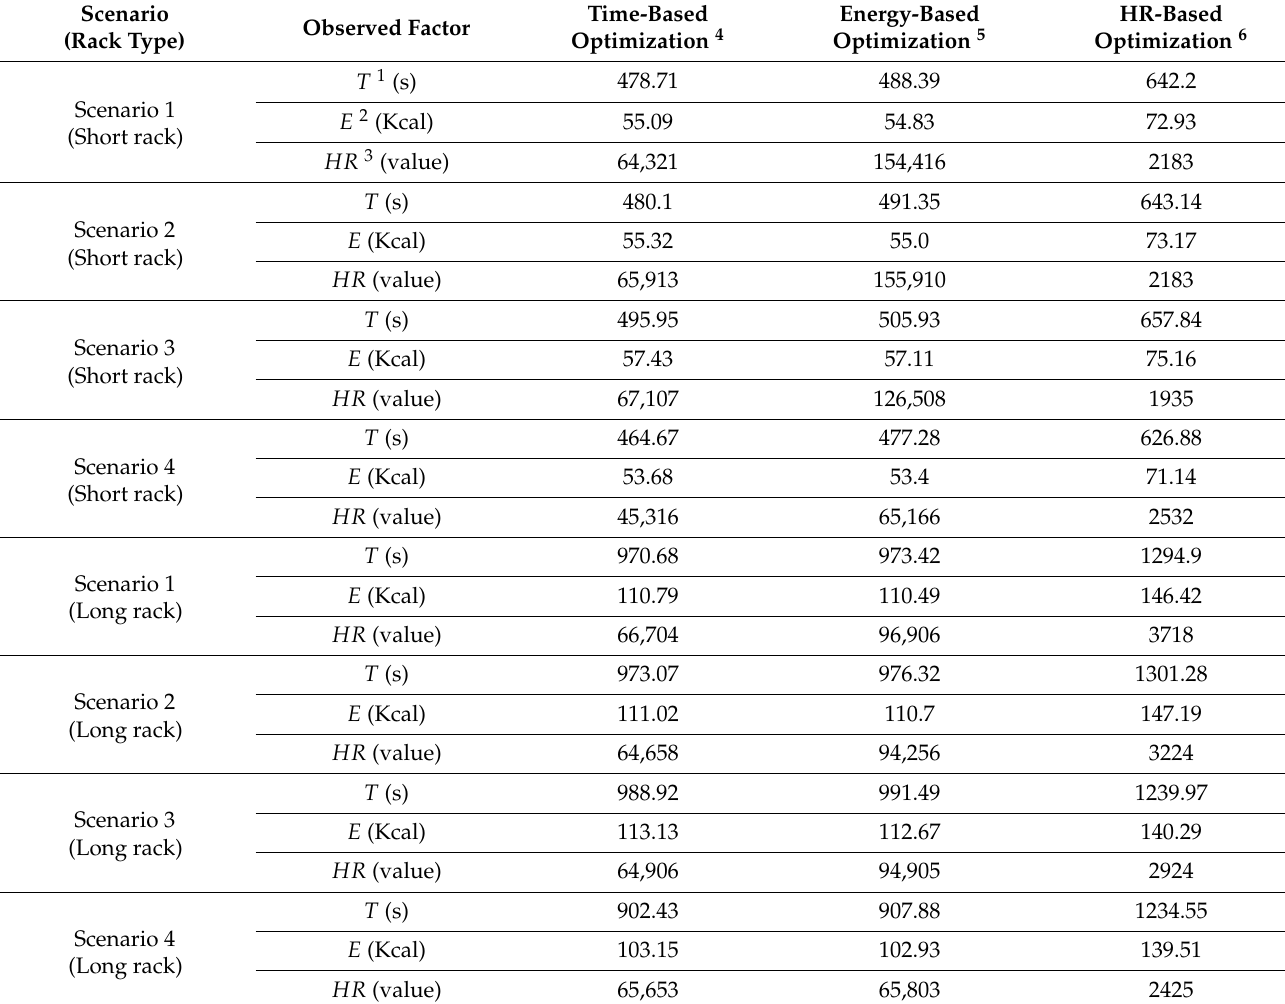
Table 6. Comparison of results for different scenarios, rack type and single-objective